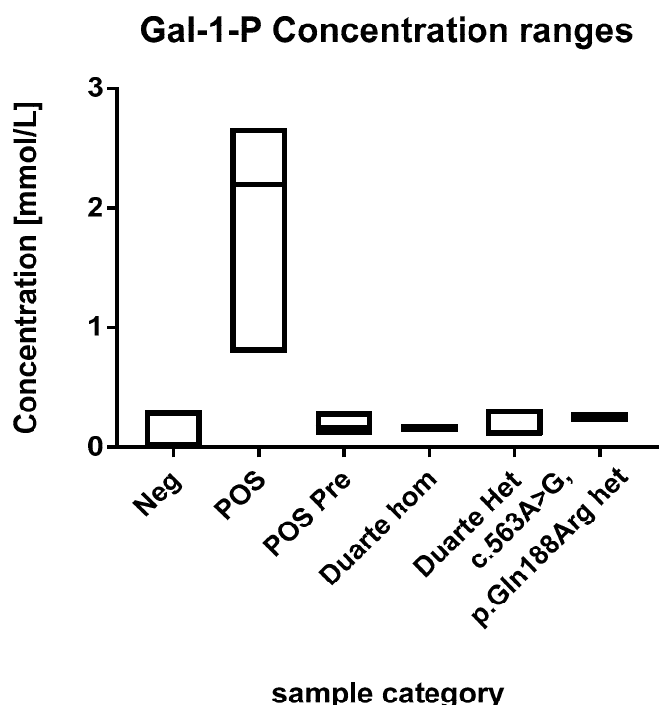
Figure 2. Ranges of the GAL-1-P concentrations. Each box describes the full range of the sample categories. The median values are depicted with a line within the boxes.